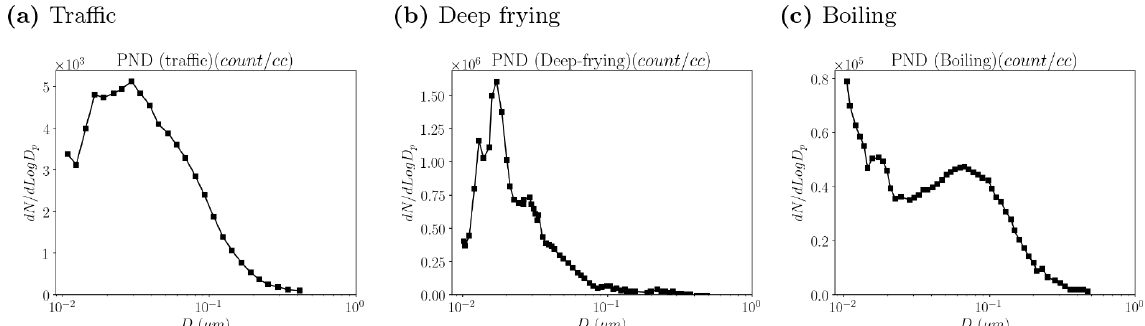
Figure 3. Reference emission spectra: (a) traffic (Janhäll et al., 2004); (b) deep-frying (See and Balasubramanian, 2006); (c) boiling (See and Balasubramanian, 2006). The reference spectra are scaled in order to obtain emission spectra for the scenarios of Table 1. Table 1. Emission scenarios for the area sources illustrated in Fig. 1. The dimensions of the area sources are expressed in terms of the canyon dimensions ( W,L,H ) when the source extends along the full extent of the canyon in a given direction, and ( w,l,h ) otherwise. For the isolated cooking emissions, z 0 /H ∈ { 0 . 05 , 0 . 50 , 0 . 95 } . Case Type Location Source dimensions TR Traffic Ground level (centred at x/W = 0) w = 10m, L NG-D Deep-frying Near-ground L , h = 2m NG-B Boiling Near-ground L , h = 2m CO-D Deep-frying Column (centred at y/W = 1) l = 2m, H CO-B Boiling Column (centred at y/W = 1) l = 2m, H I-D- z 0 Deep-frying Isolated (centred at y/W = 1 ,z/H = z 0 ) l = 2m, h = 2m I-B- z 0 Boiling Isolated (centred at y/W = 1 ,z/H = z 0 ) l = 2m, h =